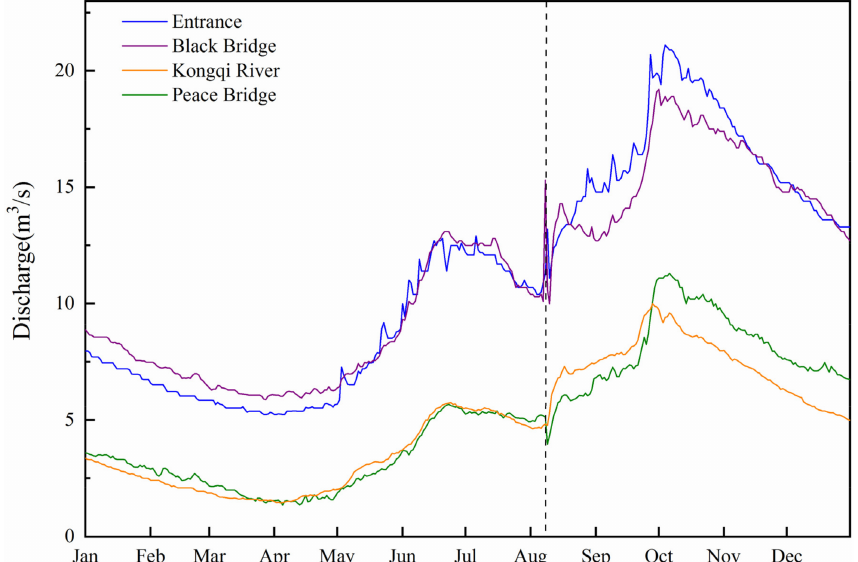
Figure 4. Hydrographs of four hydrologic stations in the Rize (RZ) and Shuzheng (SZ) rivers in 2017. The dashed black line represents the Mw6.5 earthquake. The discharge data are presented in Table S1 of the